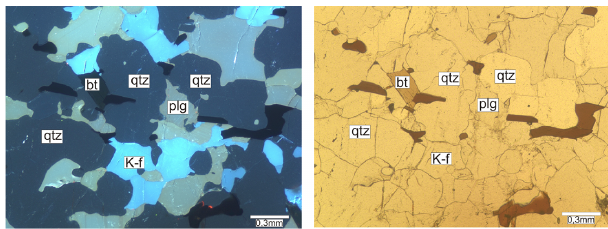
Figure 6. CL (right) and true-color (left) images of the migmatitic kinzigite (sample Ar949) displaying the intense homogenous dark blue of quartz grains.